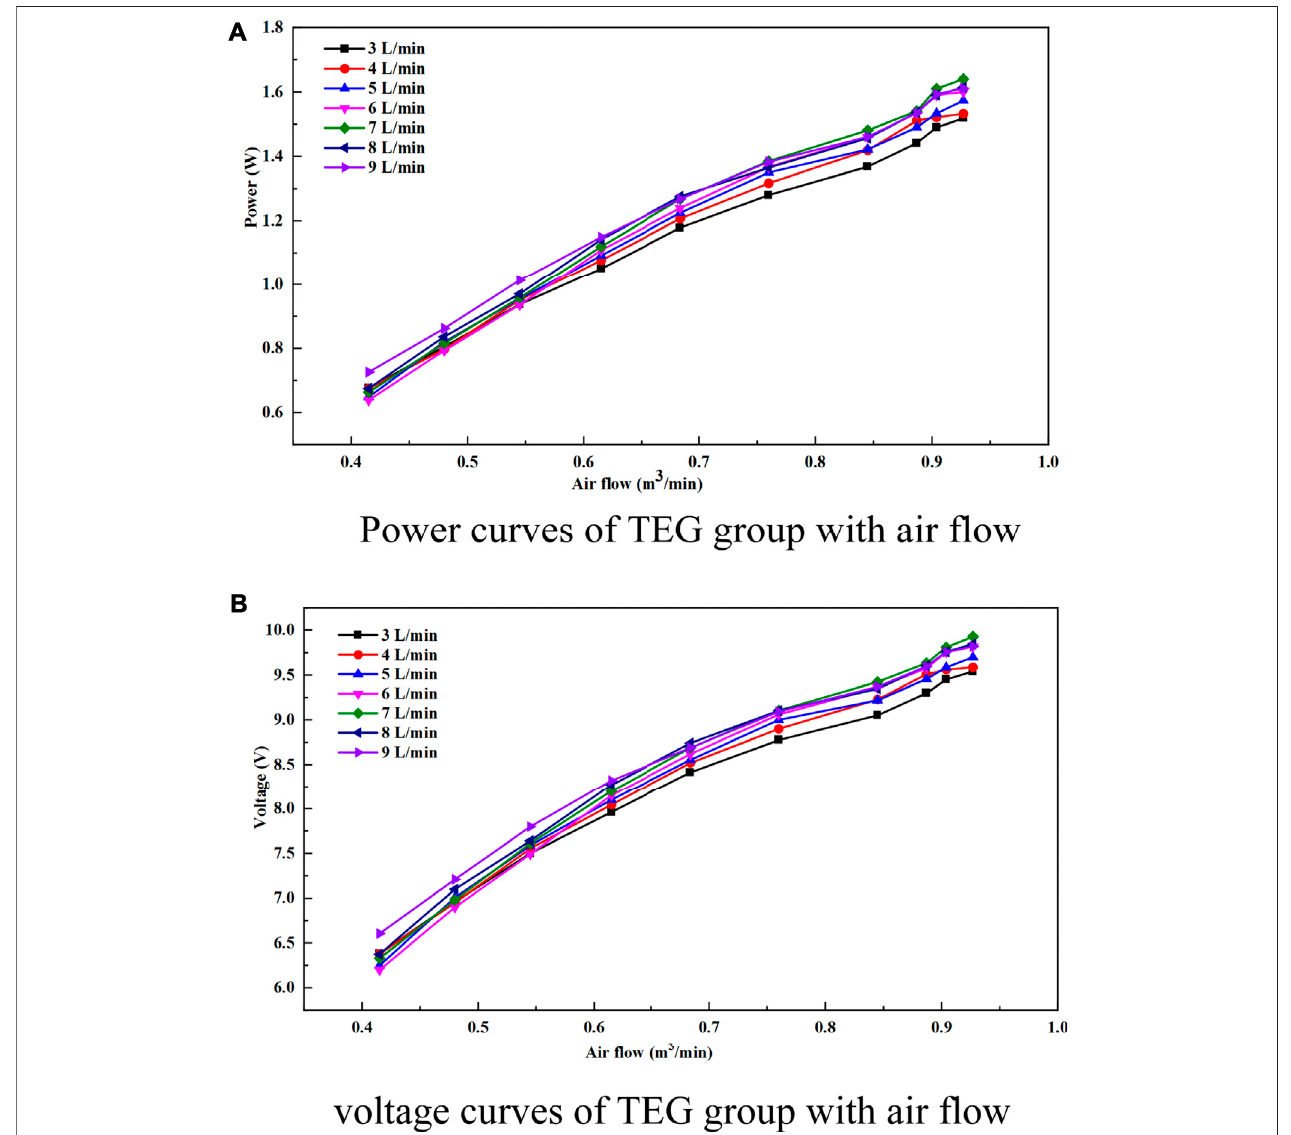
FIGURE 7 | (A) Power curves of the TEG group with air fl ow. (B) Voltage curves of the TEG group with air fl ow.